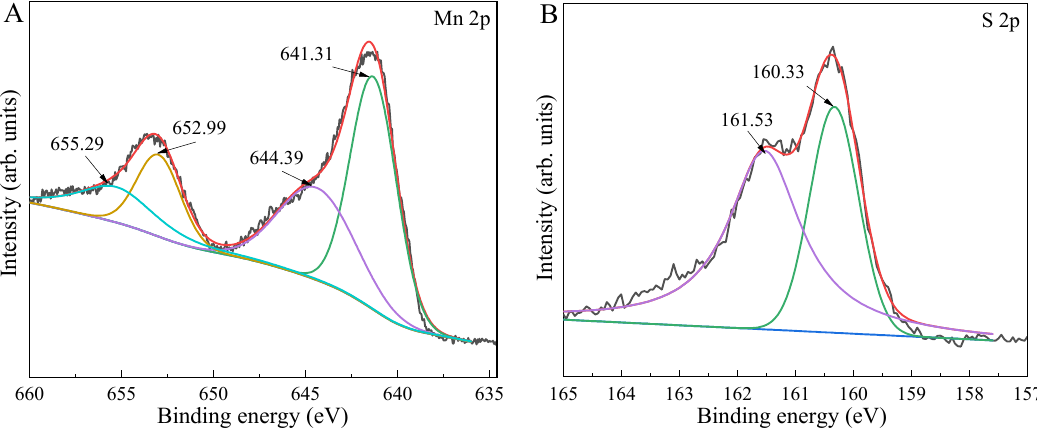
Figure 5. PL spectra of MnS treated at different temperatures. The adsorption and photocatalytic behaviors of MnS were carried out for the re- moval of TCH in visible light region (Figure 6). The adsorption-photocatalytic activity of MnS was greatly affected by pH, hydrothermal temperature, hydrothermal time, and inorganic salts [47,55,62]. Due to the electrostatic attraction between obtained MnS and TCH for efficient adsorption of TCH from aqueous solution at pH of 3.3~10.75, the re- moval efficiency of TCH was greatly affected by photo-induced radicals such as O 2- and OH. The high pH is not favorable for the formation of OH in photocatalytic system, leading to the inferior photocatalytic activity of photocatalysts [13,63]. Hence, the optimal pH was 4.36 for TCH removal over MnS. With the increasing hydrothermal temperature, the adsorption and photocatalysis efficiencies of MnS for TCH solution of 260 mg L − 1 (Figure 6A) increased and then decreased within 180 min, of which the best removal ef- ficiency of TCH over MnS treated at 433 K for 12 h was 94.83%. In contrast with the re- ported works, the removal efficiency of MnS (Table S2) was better, suggesting that octa- hedral MnS was a potential adsorption-photocatalytic material for wastewater treatment [63,64]. The adsorption-photocatalytic efficiency of MnS (Figure 6B) increased and then decreased with an increase in hydrothermal time. The main reason was that the hydro- thermal temperature and time intensively affected the crystallinity of MnS. The high hy- drothermal temperature and time induced to the decreased numbers of S defect sites, suppressing the adsorption and photocatalysis activity of MnS [49,51]. TCH molecules diffused from aqueous solution to vacant sites of bulk surface, meanwhile the decomposed intermediates and products escaped from active sites of solid surface [36,47,61]. This pro- cess was seriously affected by the high concentration of TCH. As plotted in Figure 6C, the